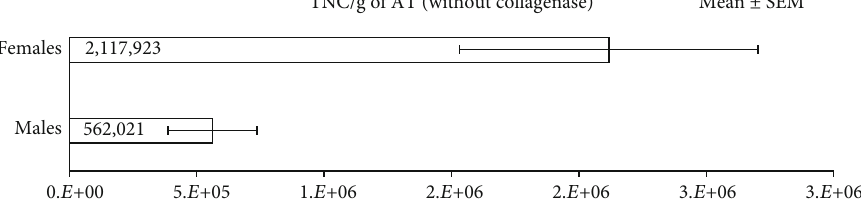
Figure 4: Comparison of mean total nucleated cells in the SVF per gram (TNC/g) of adipose tissue when treated without collagenase between females ( n = 5 , mean age 58, mean BMI 30) and males ( n = 8 , mean age 40, mean BMI 32) ( p value = 0.00006).